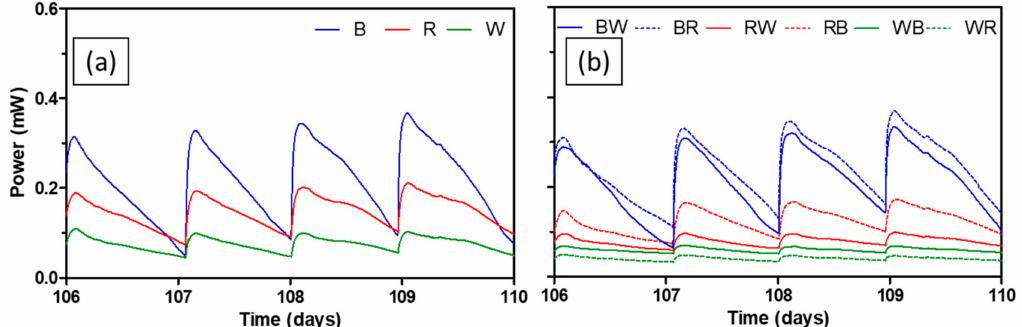
Figure 6. Power output levels of MFCs with test ceramics between day 106 and day 110; single composition ceramics ( a ), spotty ceramics ( b ). Data represent average values from triplicates of each ceramic type.